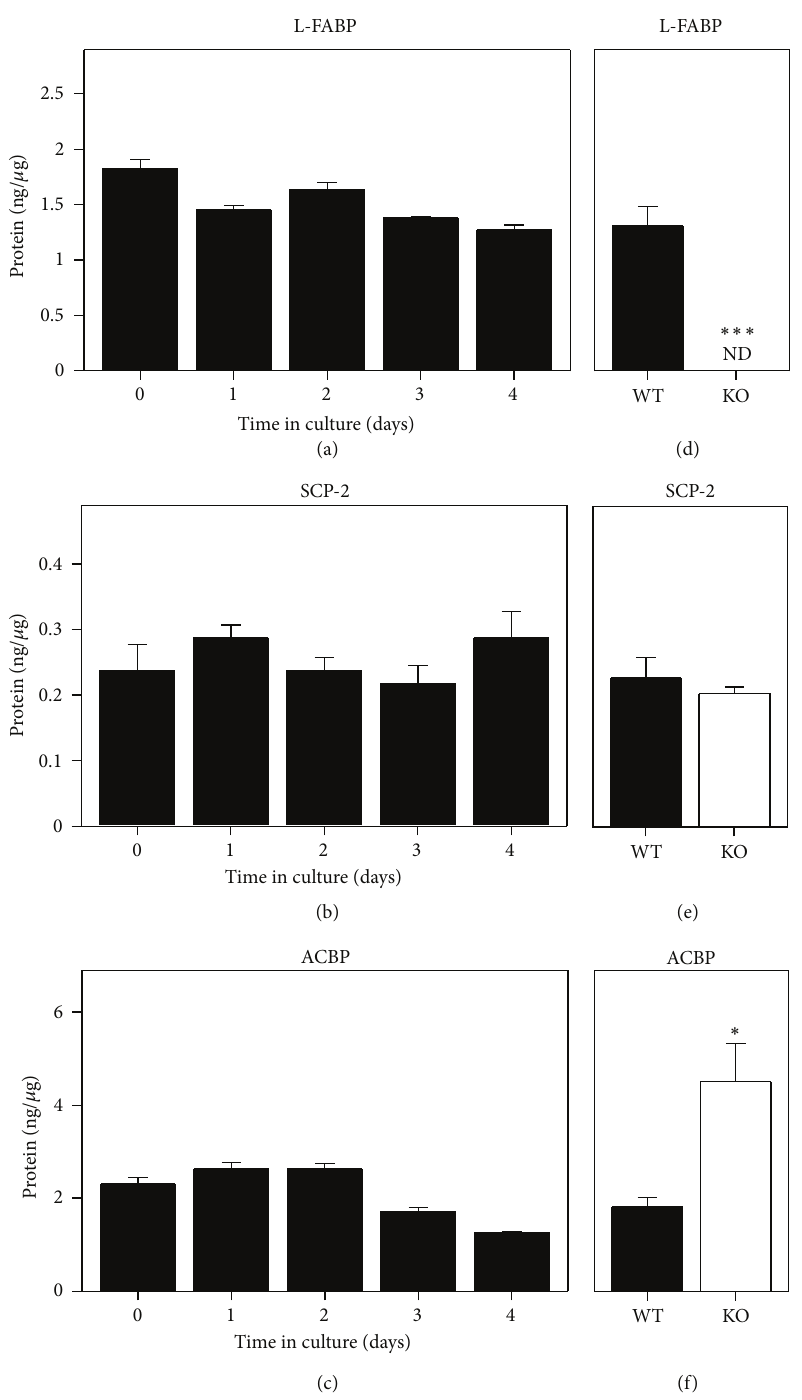
Figure10:ExpressionofLCFAandLCFA-CoAbindingproteinsinculturedmouseprimaryhepatocytes.Primaryhepatocytesfromwild-type and L-FABP null mice were isolated from mouse livers and maintained in culture for up to four days as described in Methods. Quantitative western blotting was performed by comparison to a standard curve of known amounts of the respective recombinant L-FABP, SCP-2, or ACBP on the same blot as described in Methods. Quantitative western blots were obtained as a function of increasing time for wild-type hepatocytes in culture: (a) L-FABP; (b) SCP-2; and (c) ACBP. Time 0 = concentration in liver while time of 1–4 days indicates time in culture. For determining the effect of L-FABP gene ablation on expression of these proteins, quantitative western blots of (d) L-FABP; (e) SCP-2; and (f) ACBP were also obtained for hepatocytes from wild-type (WT) and L-FABP null (KO) hepatocytes after three days in culture. Mean ± SEM, 𝑛 = 3 – 6